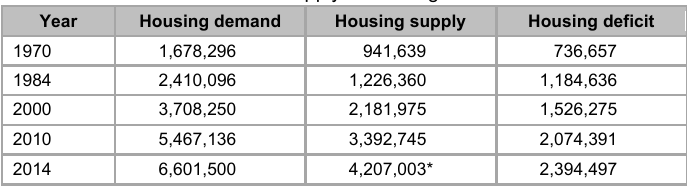
Demand and supply of housing in Ghana Year Housing demand Housing supply Housing